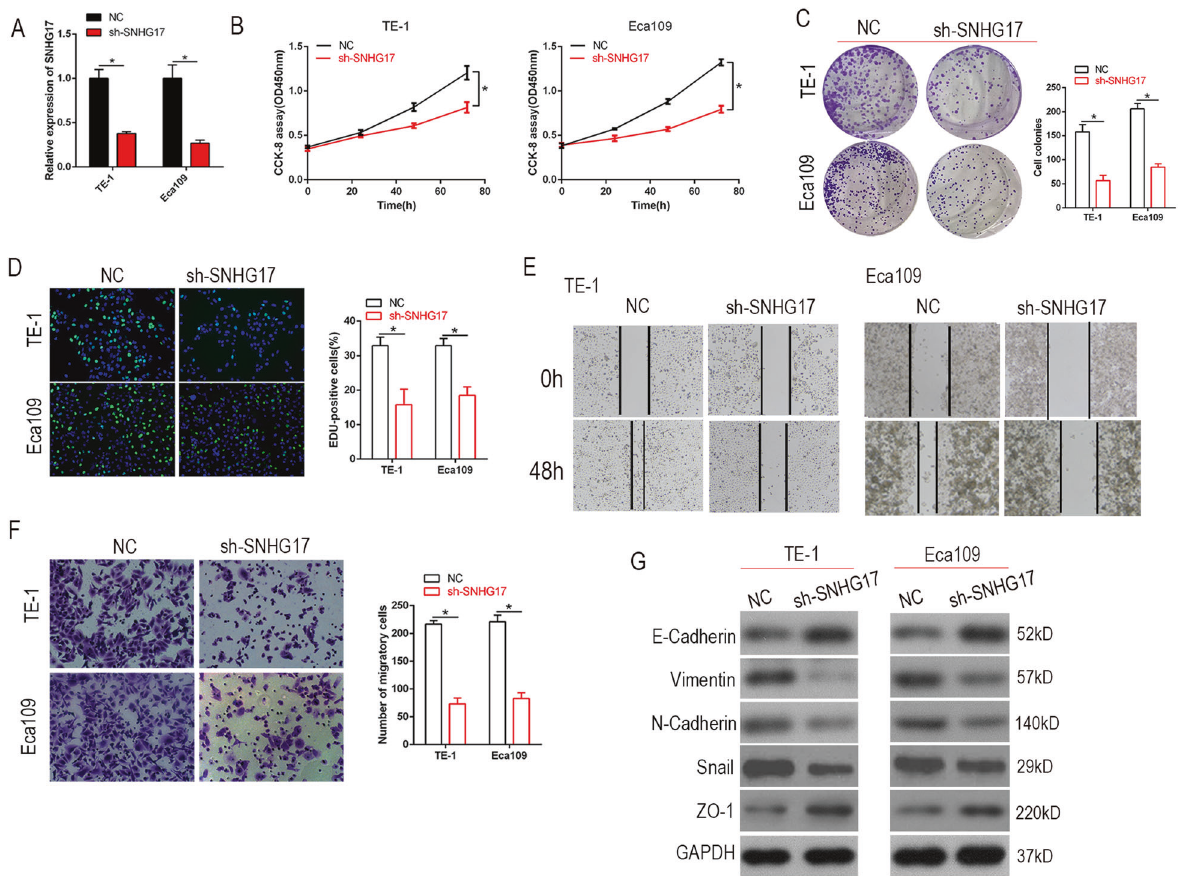
Fig. 2 SNHG17 knockdown suppresses ESCC cell proliferation and migration and EMT in vitro. A The expression of SNHG17 was knockdown by shRNA in both Eca109 and TE-1 cells. * P < 0.05 vs. NC. B , C CCK-8 and colony formation assays indicated that SNHG17 knockdown inhibited ESCC cell proliferation. * P < 0.05 vs. NC. D EdU immunostaining assays displayed that cell proliferation was restrained by sh-SNHG17 in Eca109 and TE-1 cells. * P < 0.05 vs. NC. E , F Wound healing and transwell assays were performed to detect the effect of sh- SNHG17 on cell-migration ability. * P < 0.05 vs. NC. G Western blot assay revealed that depletion of SNHG17 could reverse the EMT phenotype of Eca109 and TE-1